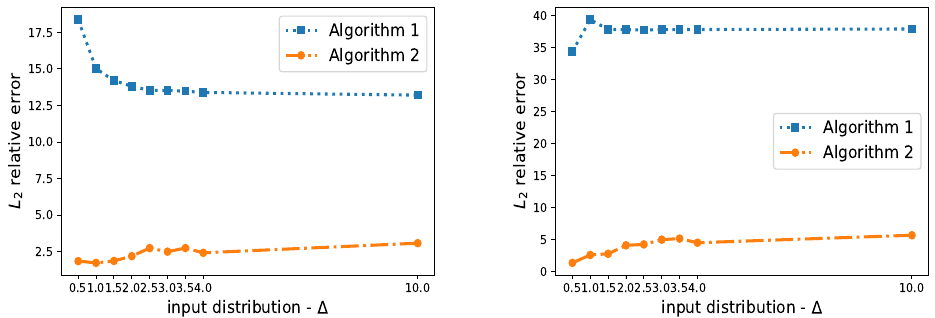
Figure 6. Fed-DeepONet G θ ∗ (Algorithms 1 and 2) performance change on the in-distribution ( left ) and out-of-distribution ( right ) test trajectories when we increase the input functional data heterogeneity by increasing control parameter ∆